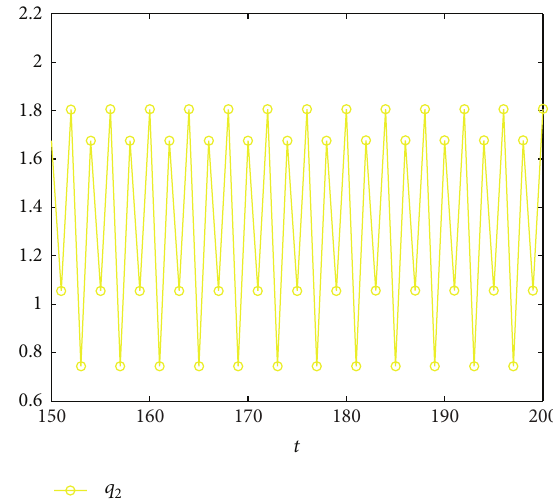
Figure 12: The wave plots of the output 𝑞 2 with the change of time when 𝛼 1 = 1.02 , 𝛼 2 = 1.46 and 𝜃 = 0.397